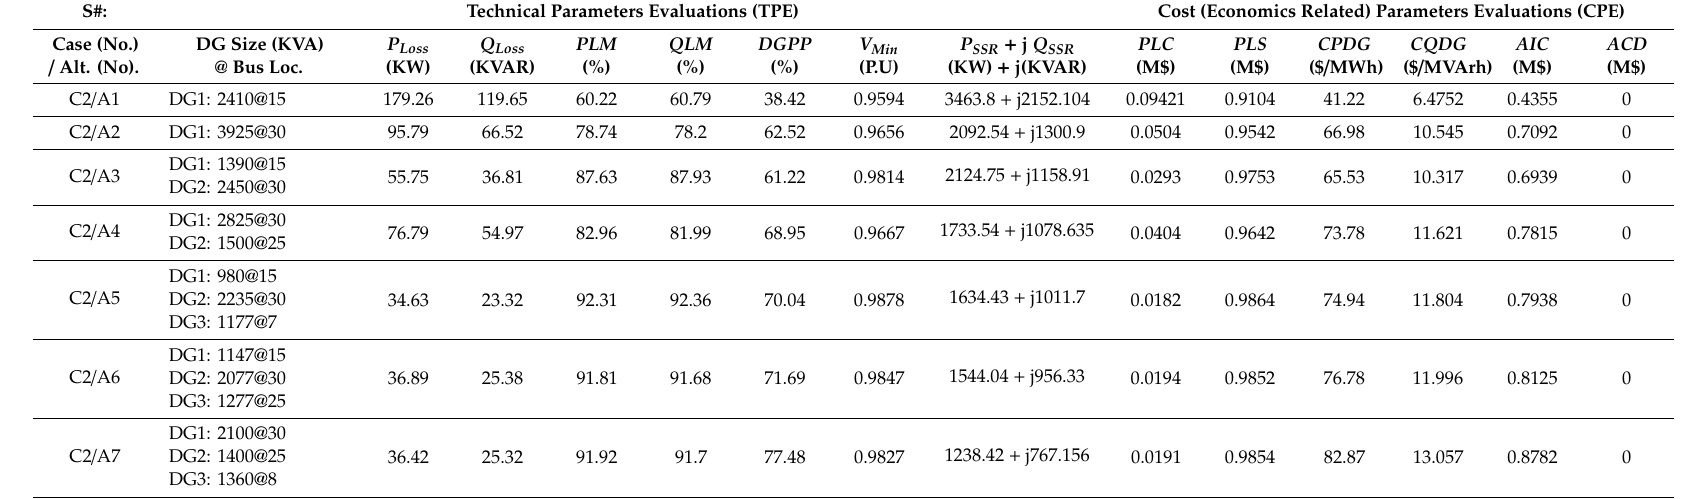
Table 23. Techno-economic evaluation analysis in case 2 (C2_OLG) for 33-bus